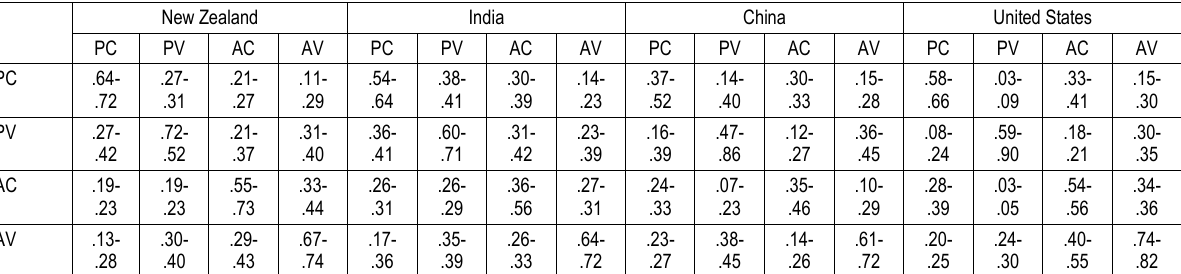
Note: Table shows range of correlations of individual scale items with the scale composite scores of the 4 vanity dimensions – Physical Concern (PC), Physical View (PV), Achievement Concern (AC), and Achievement View (AV). For example, the range of correlations of the 5 PC scale items with the PC scale composite .64 to .72 in New Zealand. The correlations of PC scale items with PV scale in New Zealand range from .27 to